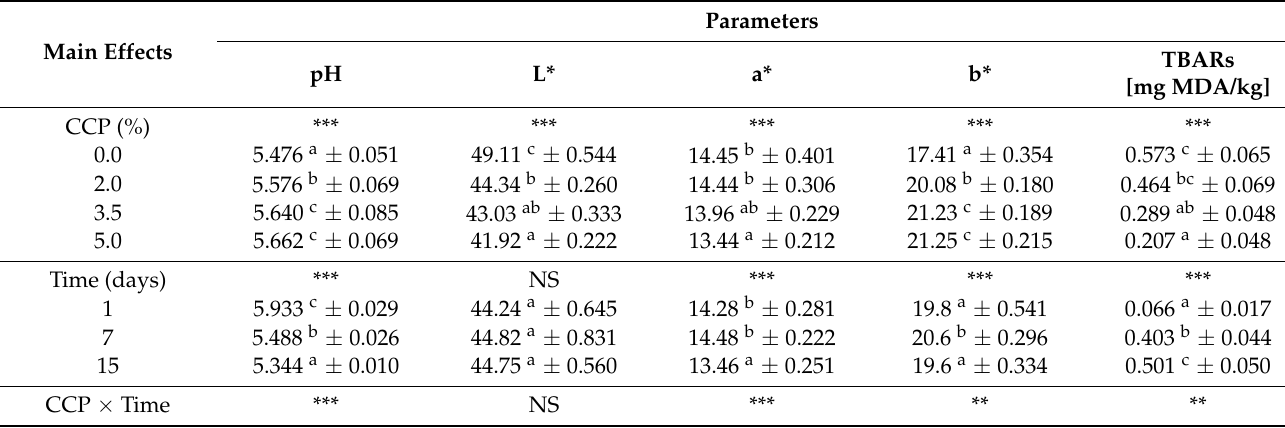
Table 2. Physicochemical parameters determined in vacuum-packed ground beef containing different levels of camu-camu powder and stored at 5 ◦